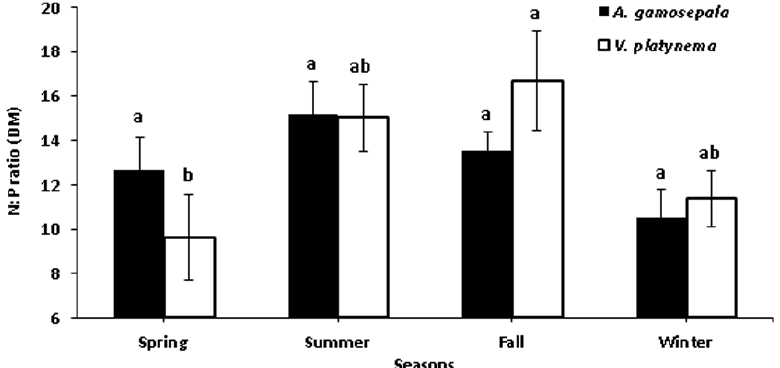
Figure 4. N:P ratio in leaves of Aechmea gamosepala and Vriesea platynema sampled in different seasons. The ratio was calculated from the percentages of the elements N and P present in the dry mass (DM). Bars represent standard errors of the mean.